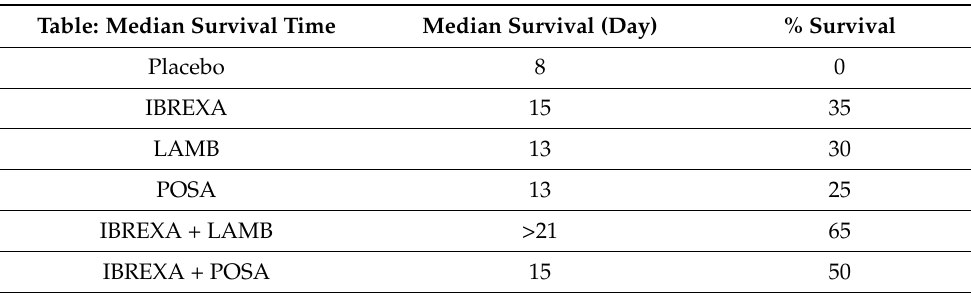
Table: Median Survival Time Median Survival (Day) %